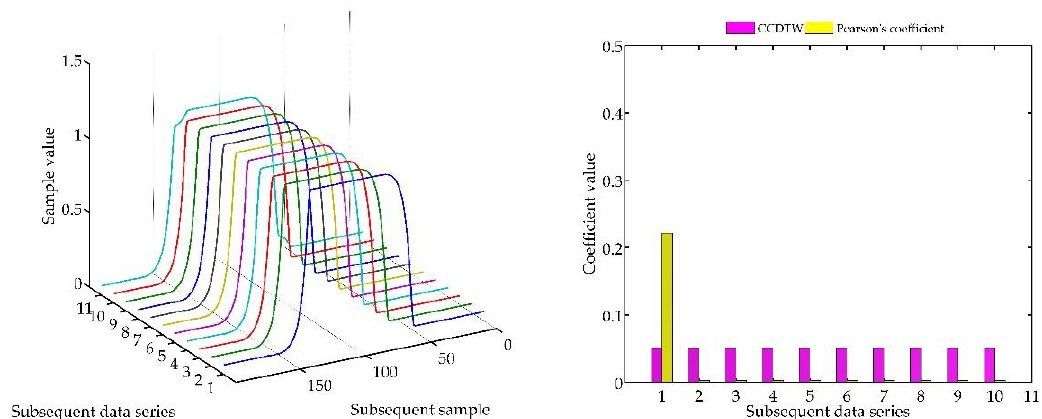
Figure 9. Simulation results achieved for data shifted by − 10 samples for the first series (blue line) for r ampl = 2.